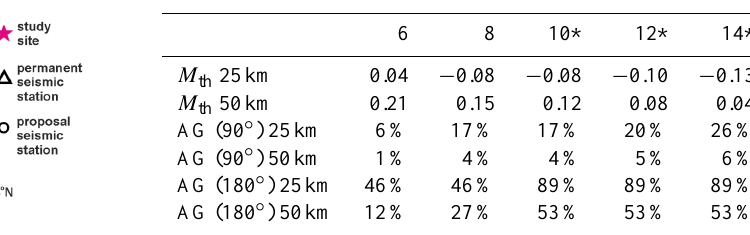
Table 1. Comparison of simulated networks having 6, 8, 10, 12, and 14 stations. Average threshold magnitude ( M th ) and the area with azimuthal gap (AG) smaller than 90 and 180 degrees are sum- marized. The area is given as the percentage of the total area (within 25 and 50km radius of the PNPP) fulfilling the AG requirement.